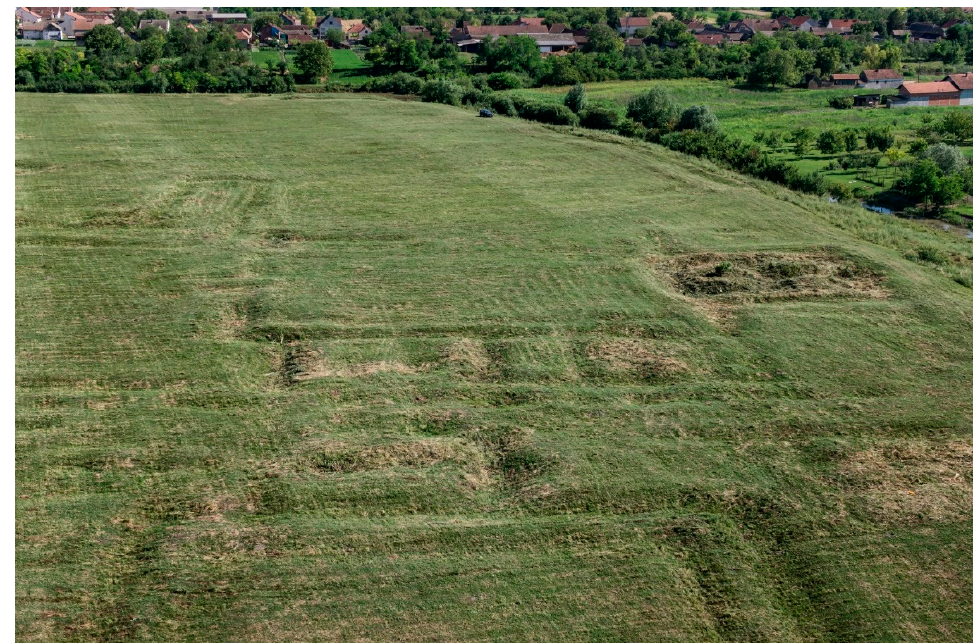
Figure 4. An oblique aerial photograph portraying the central and southern zone of the site’s western part, acquired in 2014 with an unmanned quadcopter. The trenches following the former walls are still visible in the microtopography. The global contrast of the foreground has been slightly increased to enhance the visibility of the topographic undulations. Photo: Geert Verhoeven.